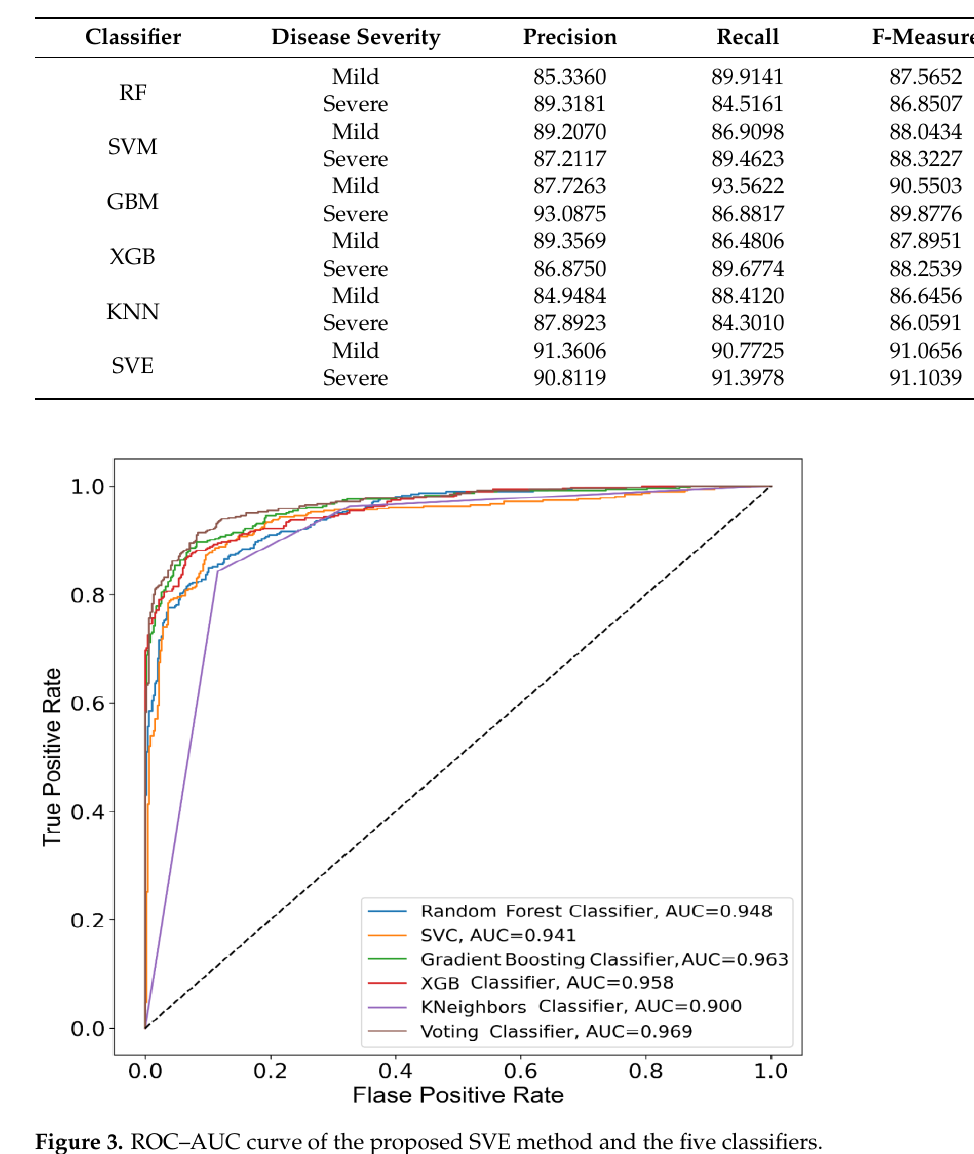
Table 5. Comparative analysis of classifiers with different stages of COPD patients (%).